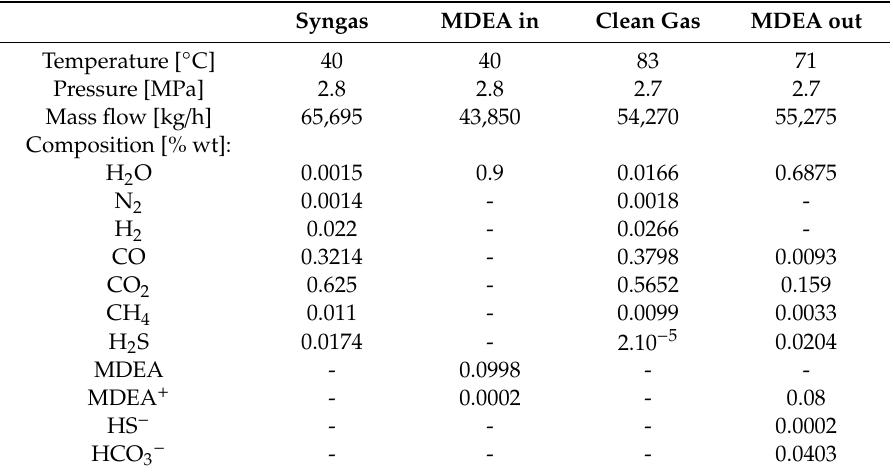
Table A4. Detailed MDEA absorption column operation simulation